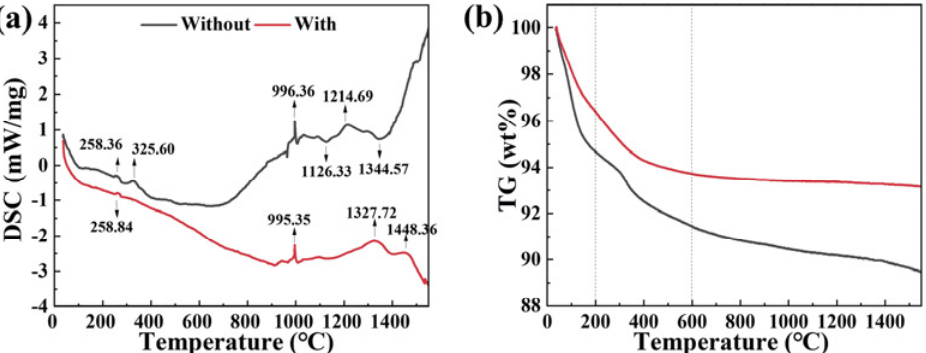
Fig. 8 (a) DSC and (b) TGA curves of the samples with and without ion exchange, analyzed at a heating rate of 10 /min in ℃